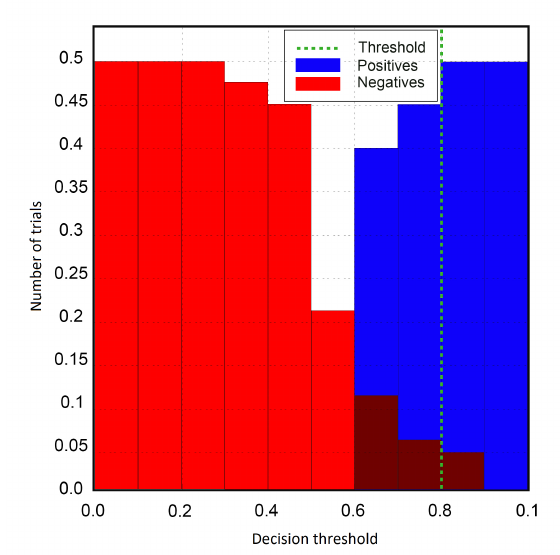
Figure 4. Genuine users’ and zero-effort imposters’ score distribution while a decision threshold τ was determined with a vertically drawn dashed line, while the x-axis represents the value of decision threshold τ , and the y-axis represents the number of